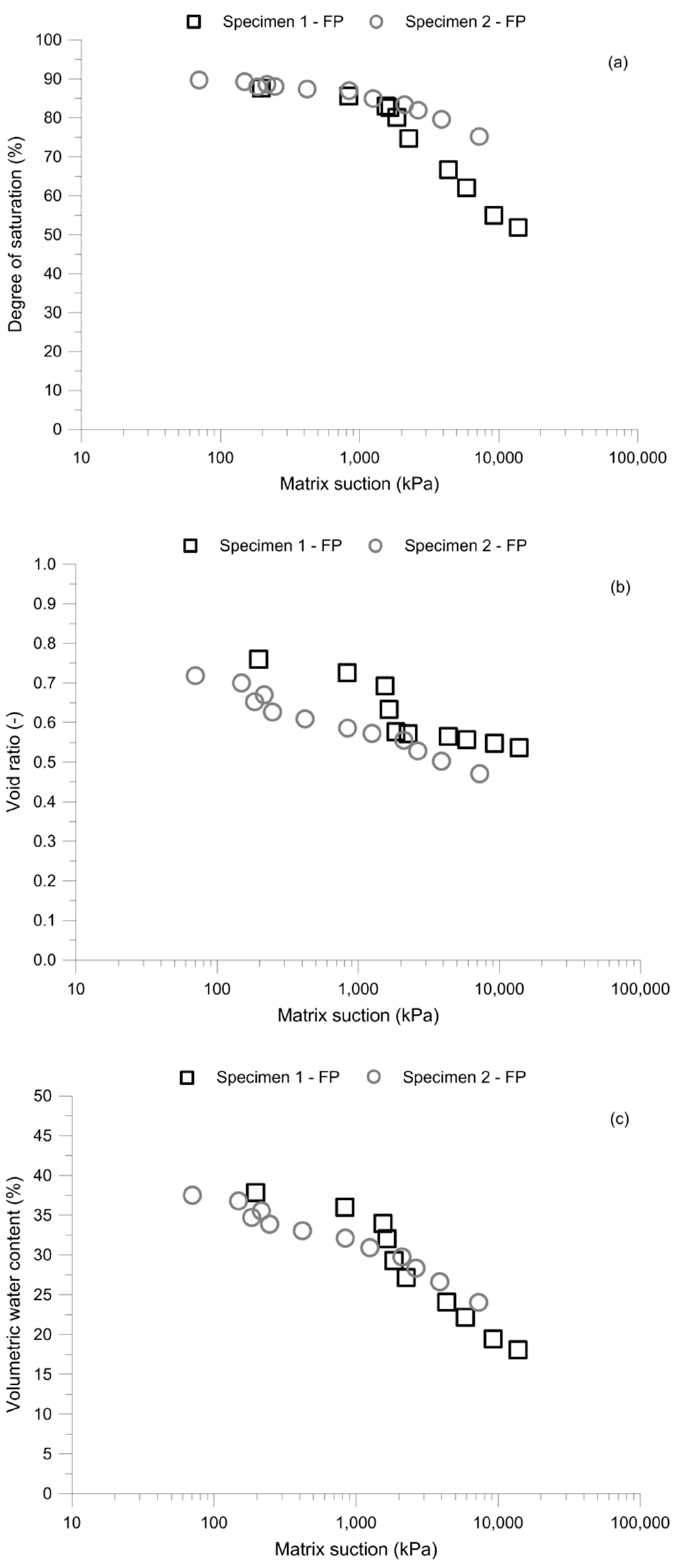
Figure 6. Representative water retention data of the Paola Doce fissured clay reported in terms of matrix suction (measured with the filter paper technique, FP) against: ( a ) degree of saturation; ( b ) void ratio; ( c ) volumetric water content.